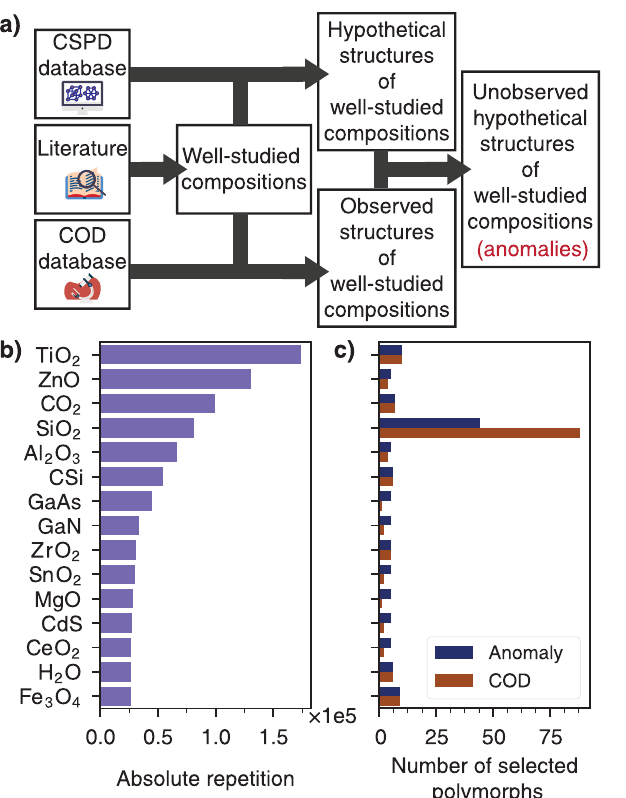
Fig. 3 Classi fi cation performance evaluation of the supervised and unsupervised models. The receiver operating characteristic (ROC) curves for the ( a ) CNN and ( b ) CAE + MLP classi fi ers shown by the red line. Each classi fi er ’ s ROC is compared with a dumb classi fi er, which randomly assigns class labels, shown by blue dashed lines. The normalized distribution of synthesizability likelihood of crystals in the test set are represented for ( c ) the CNN classi fi er and ( d ) the CAE + MLP classi fi er. e The main classi fi cation metrics based on a decision threshold of 0.5. AUC stands for the area under the ROC